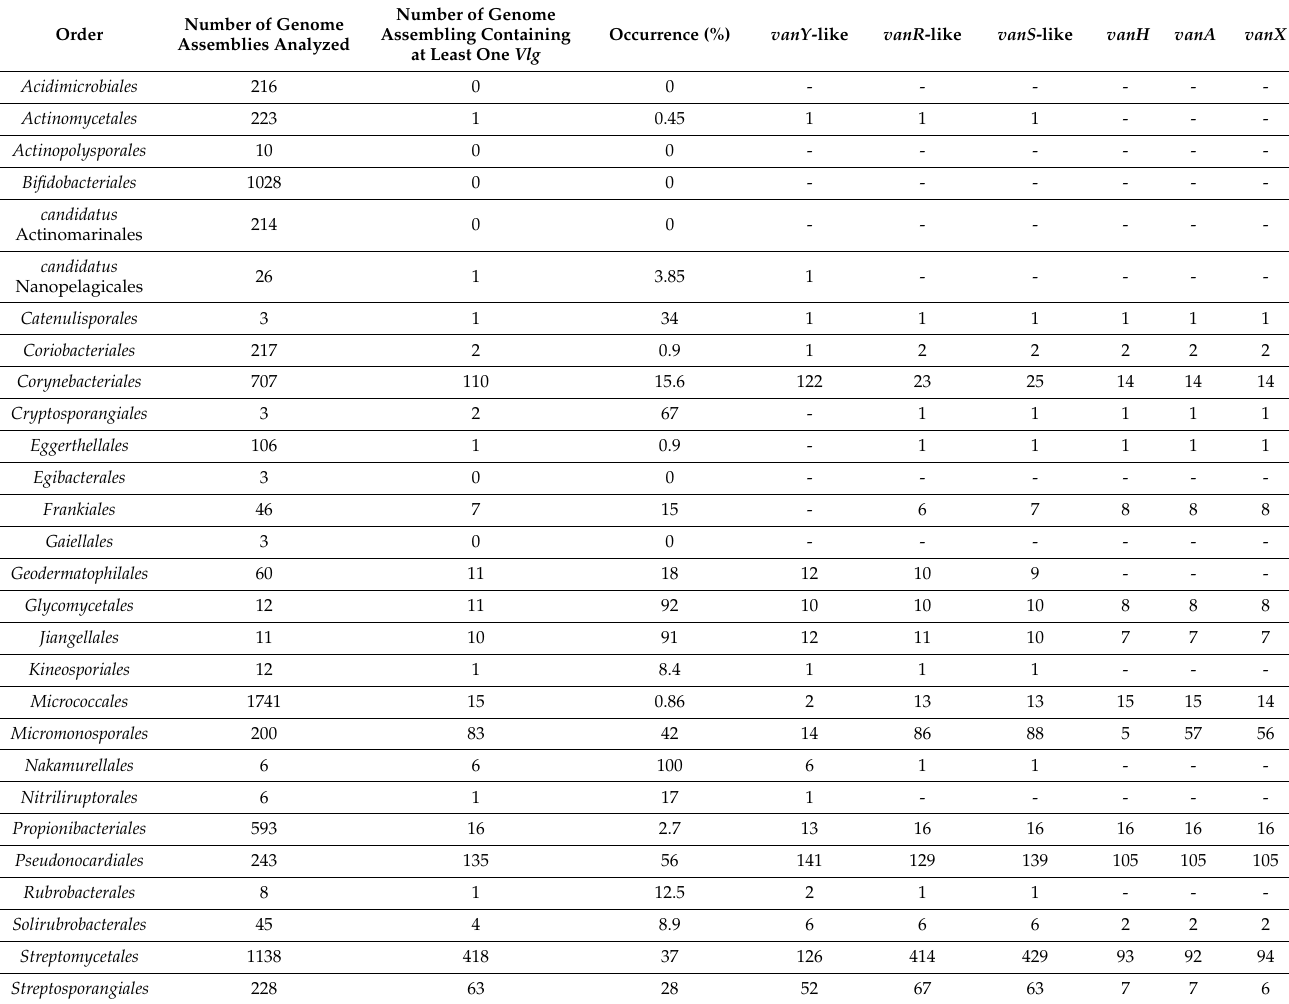
Table 1. List of orders belonging to the Actinobacteria phylum, which genome assemblies were available in GenBank at the moment of this work preparation (April 2020, Supplementary Excel File S1) and a summary of the vlgs found in them. Order Number of Genome Assemblies